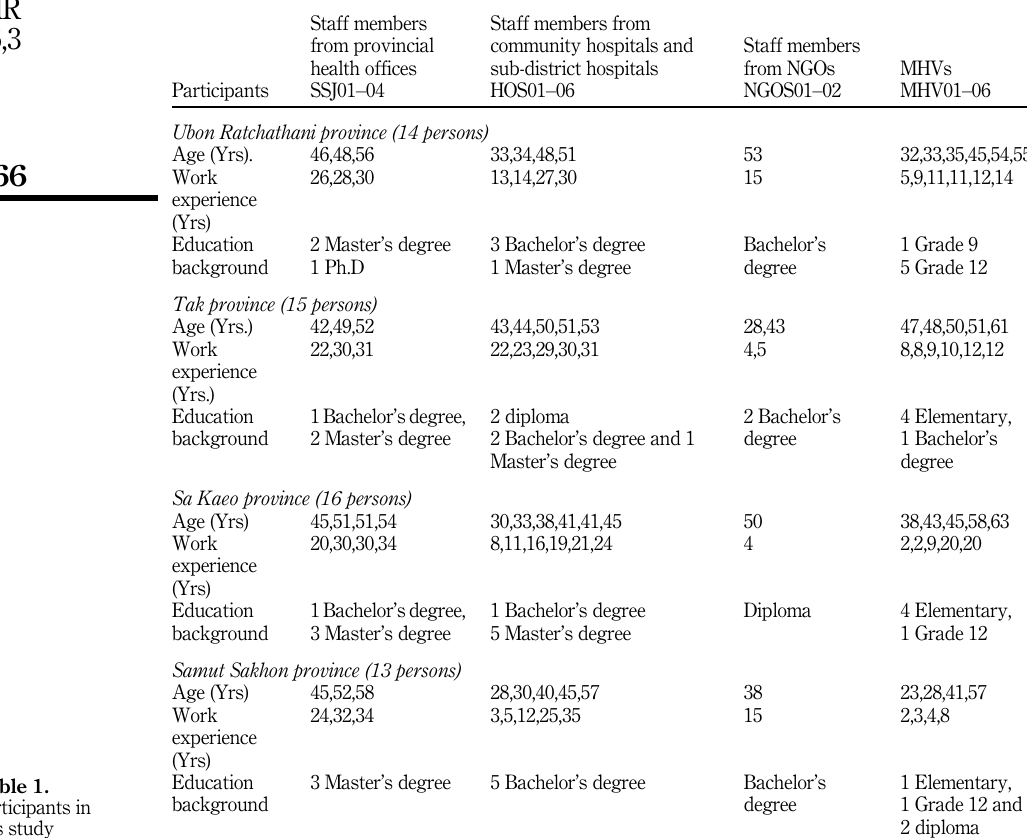
Table 1. Participants in this